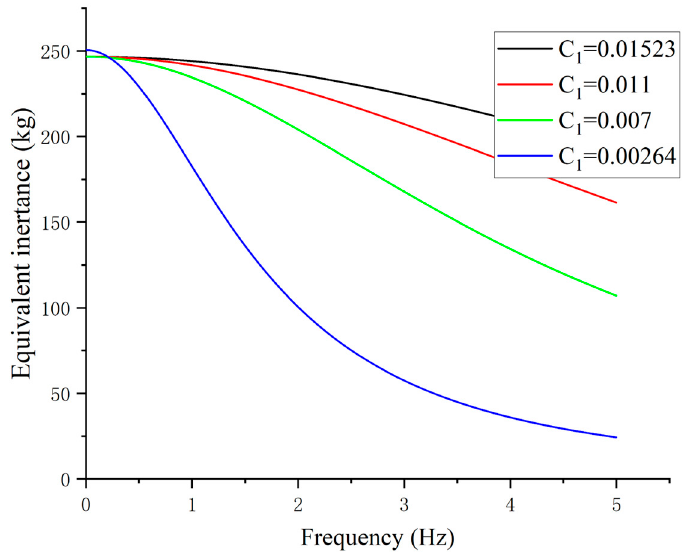
Figure 3. The equivalent inertance of VEI–VD.